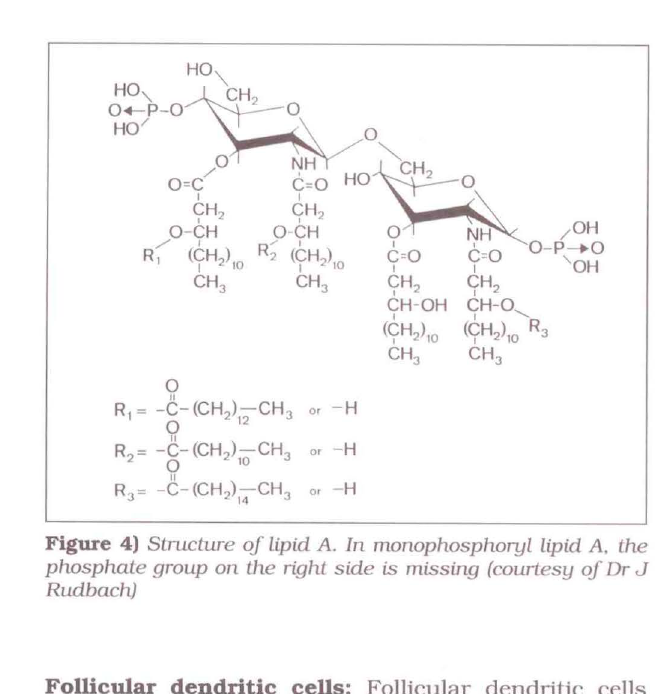
Follicular dendritic cells: Follicular dendritic cells (FDC) are found in lymphoid follicles in lymph nodes, spleen and other sites. Their branching cytoplasmic extensions are closely associated with B